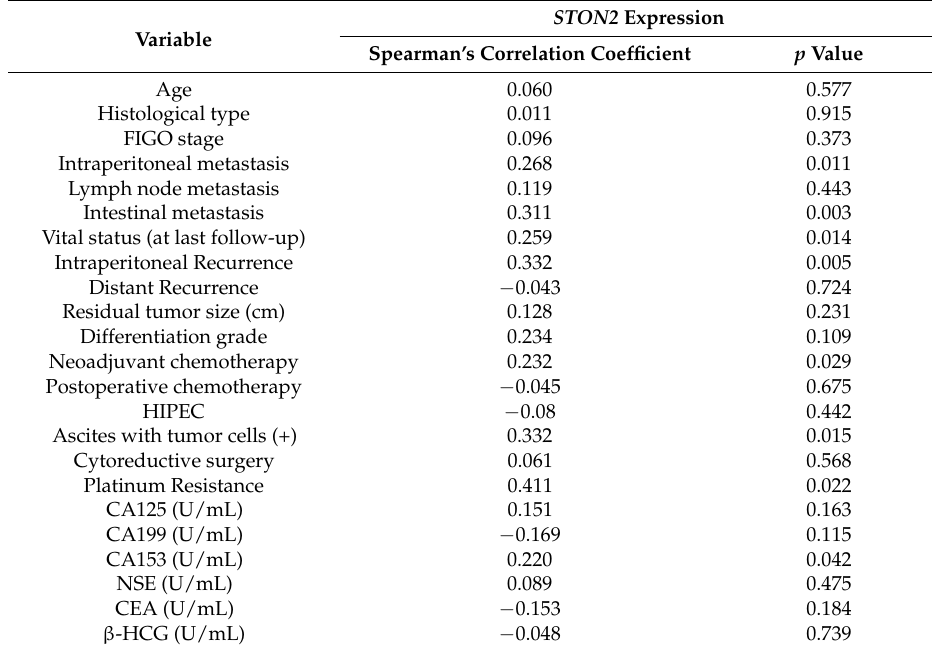
Table 3. Correlation between STON2 expression and clinicopathological characteristics of epithelial ovarian